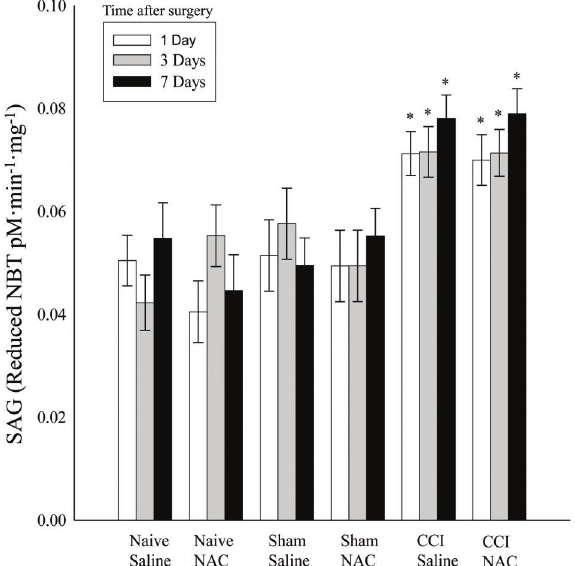
Figure 4. Superoxide anion generation (SAG) in the spinal cord of rats with chronic constriction injury (CCI) of the sciatic nerve that received 2, 4 or 8 intraperitoneal injections of saline or N- acetylcysteine (NAC; 150 mg (cid:1) kg – 1 (cid:1) day – 1 ) beginning 4 h after CCI. Rats were sacri fi ced 1, 3, and 7 days after surgery. In Sham rats, all surgical procedures involved in the CCI were used except the ligature. Data are reported as means ± SE. *P o 0.05 compared to the Naive and Sham groups (three-way ANOVA followed by Tukey post hoc